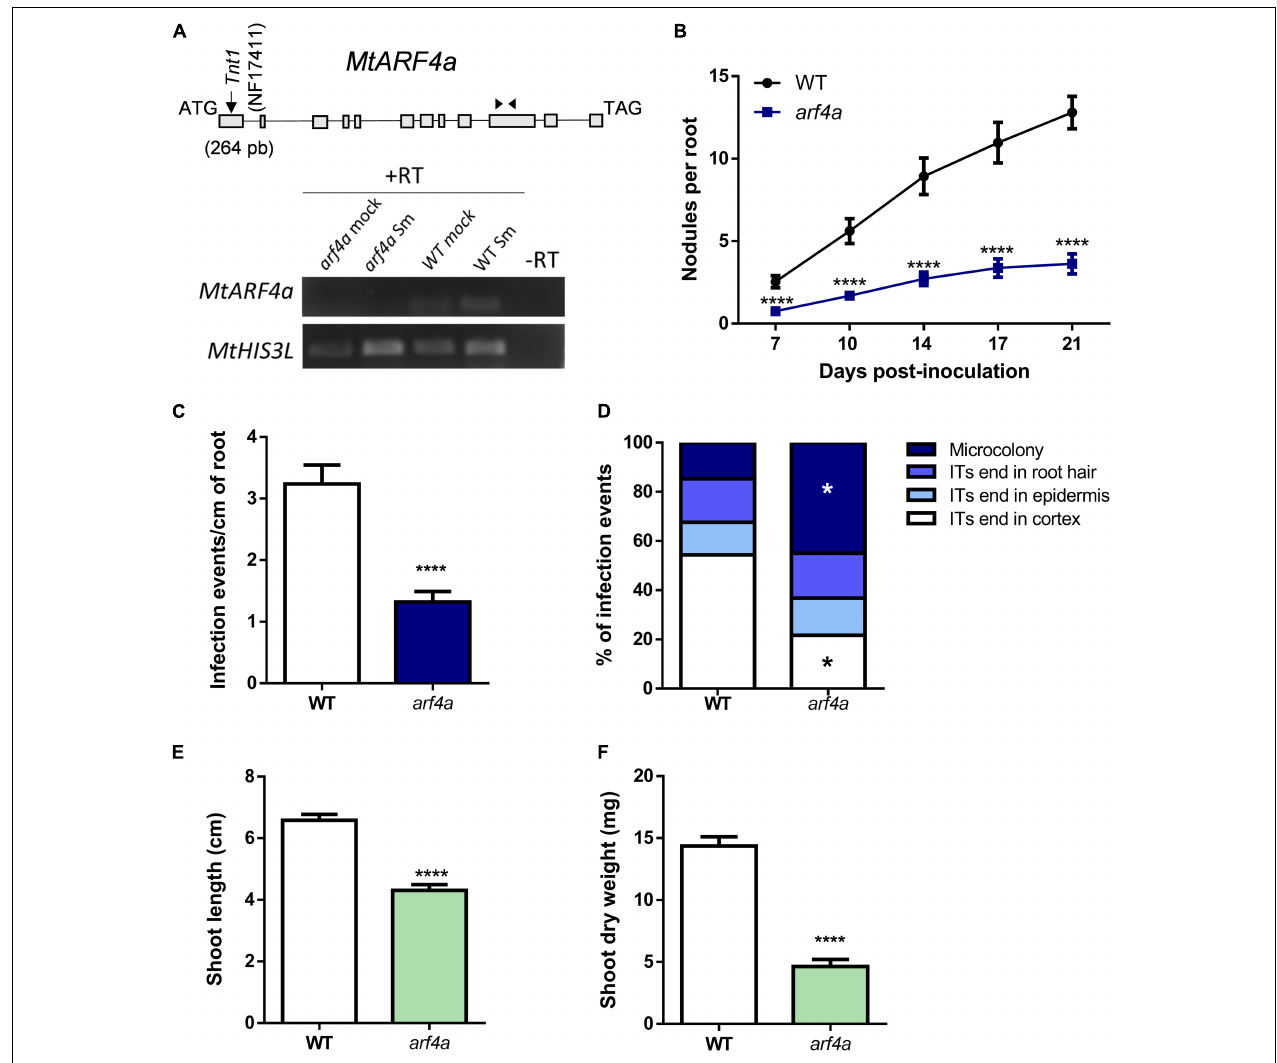
FIGURE 5 | A Tnt1 insertional mutant in MtARFa gene ( arf4a ) exhibited reduced nodulation and infection by rhizobia. (A) Schematic representation of MtARF4a gene model and the insertion of the Tnt1 transposon (upper panel). The gene model is composed of 12 exons (gray blocks) and 11 introns (lines). The position of the Tnt1 insertion within the first exon in the NF17411 mutant line is indicated in base pairs (bp) with a black arrow. Black arrowheads indicate the position of MtARF4a F and MtARF4a R primers specific for ARF4a (listed in Supplementary Table 1 ) used for RT-PCR analysis. Expression levels of MtARF4a and MtHIS3L were determined by semiquantitative RT-PCR using 35 and 25 cycles, respectively, on WT and NF17411 ( arf4a ) roots at 48 hpi with S. meliloti (Sm) or water (mock) (lower panel). (B) Time-course nodule formation in roots of WT and arf4a plants upon inoculation with S. meliloti . Error bars represent the mean ± SE of three biological replicates, each performed with at least ten plants. Four asterisks indicate statistically significant differences between WT and arf4a mutant roots in an unpaired two-tailed Student’s t test with a p value ≤ 0.0001. (C) Density of infection events developed at 7 dpi in WT and arf4a mutant roots. Error bars represent the mean ± SE of three biological replicates each performed with at least 10 plants. Four asterisks indicate statistically significant differences between WT and arf4a mutant roots in an unpaired two-tailed Student’s t test with a p value ≤ 0.0001. (D) Progression of infection events in WT and arf4a mutant roots. Infection events were classified as microcolonies or ITs that end in the root hair, in the epidermal cell layer, or reach the cortex at 7 dpi. Each category is presented as the percentage of total infection events. Results are representative of three biological replicates, each with more than 10 plants. The asterisk indicates that the percentage of microcolonies and ITs that end in cortex was significantly different in an unpaired two-tailed Student’s t test between WT and arf4a roots with p ≤ 0.05. (E,F) Shoot length (E) and shoot dry weight (F) measured in WT and arf4a mutant plants grown on free-nitrogen slanted agar-Fahraeus at 21 dpi with S. meliloti . Error bars represent the mean ± SE of three biological replicates, each performed with more than 10 plants. Four asterisks denote a statistically significant difference between WT and arf4a plants in an unpaired two-tailed Student’s t test with a p value ≤